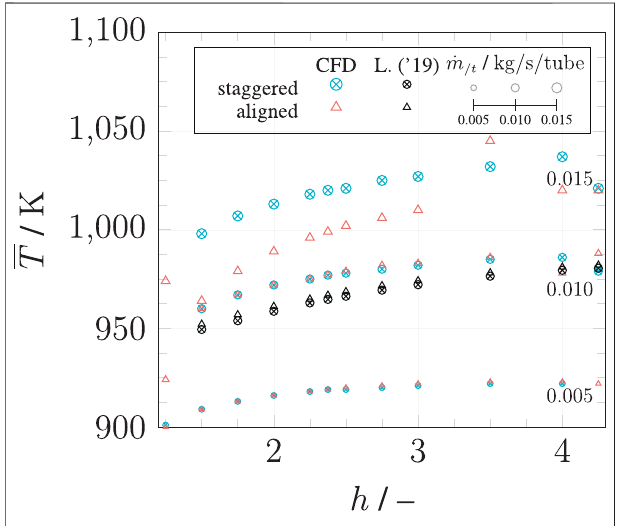
CFD model for three different mass fl ow rates whereas the black symbols denote the radiation-based model that was fi rst described in (Liesche and Sundmacher, 2019). It is evident,